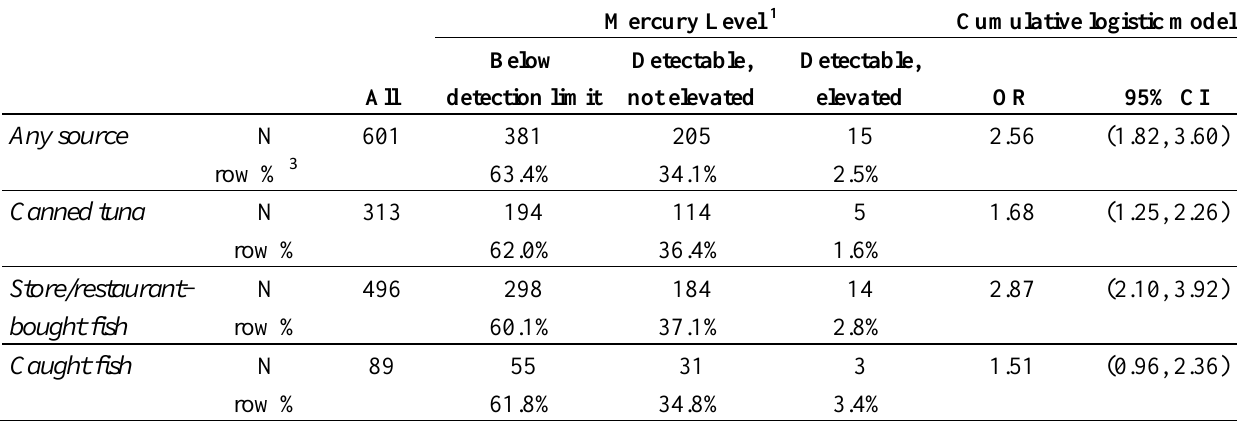
Table 3. Distribution of mercury levels among participants reporting fish consumption from various